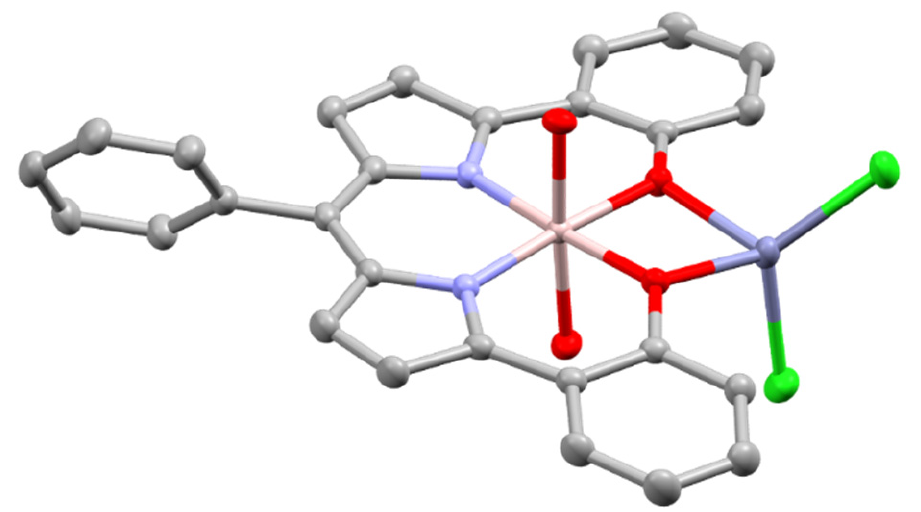
Figure 34. View of the molecular structure of Al-14 in the crystal , obtained from a 1:1 mixture of aluminum complex Al-12 with ZnCl 2 . Hydrogen atoms and non-coordinating solvent molecules are omitted for clarity; thermal ellipsoids give 50% probability [119]. The two water molecules in the axial position are represented only by their oxygen atoms. See the main text for more discussion on the properties of this compound. (CCDC number: 708972 [183]).